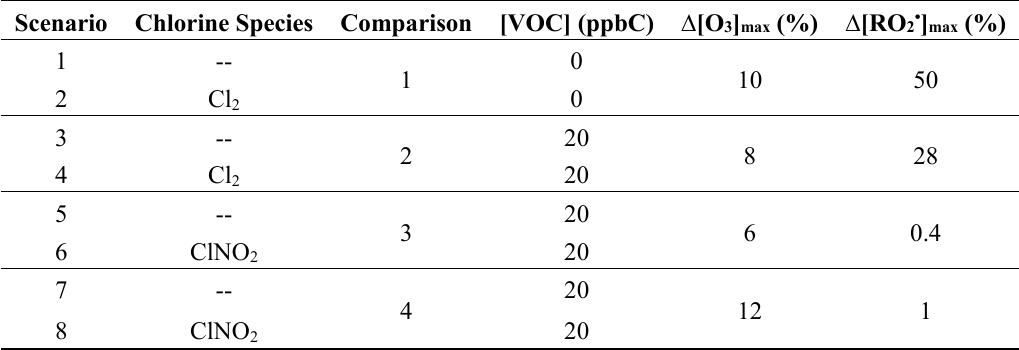
Table 1. Summary of Modeling